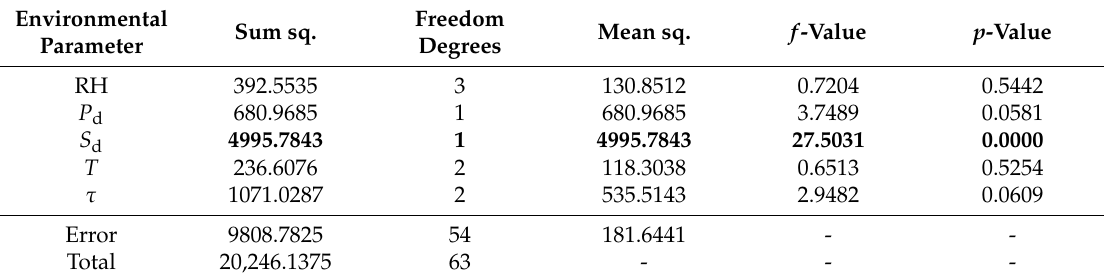
Table 3. Statistical analysis of results for carbon steel.